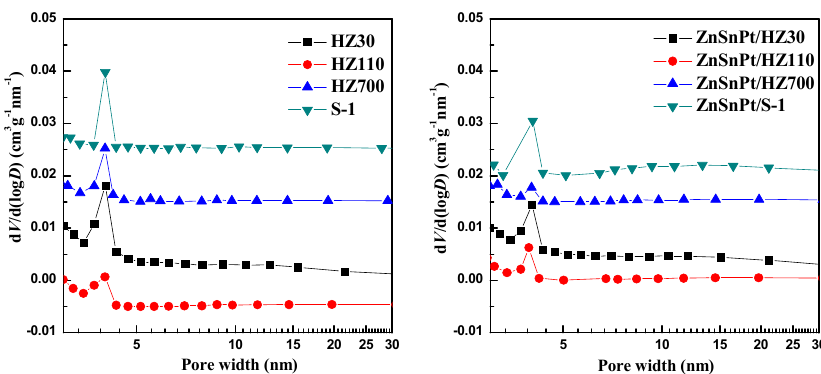
Figure 2. Pore size distribution of defective MFI zeolites ( a ) and Zn–Sn–Pt modified defective MFI zeolites ( b ) with different SiO 2 /Al 2 O 3 ratios.